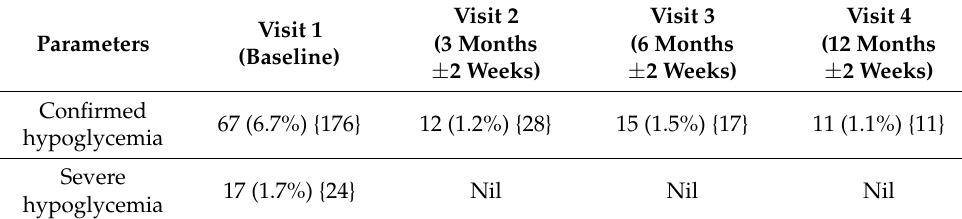
Table 4. Episodes of confirmed and severe